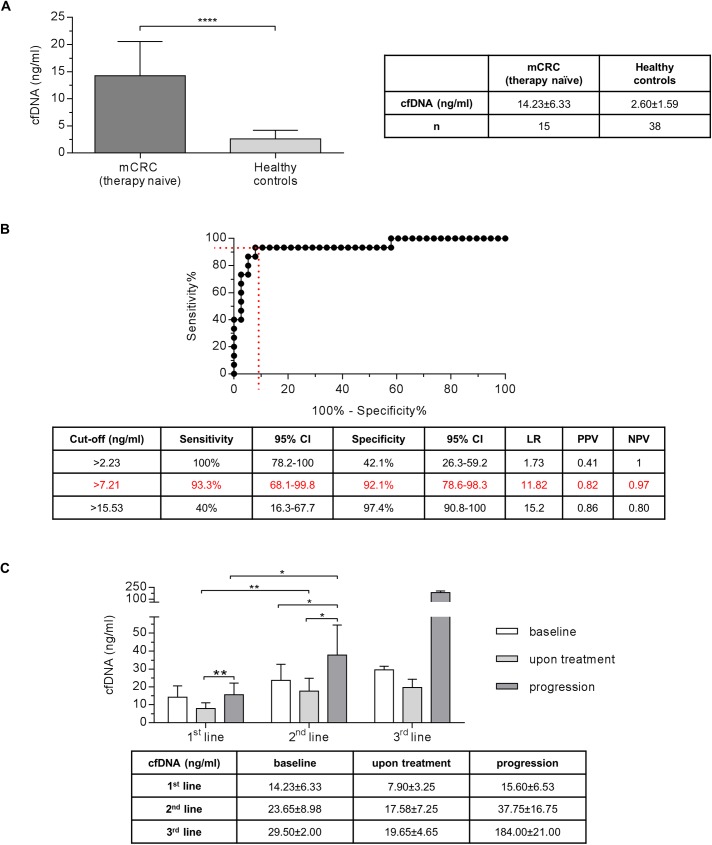
Diagnostic power of cfDNA in metastatic colorectal cancer patients and its changes under palliative treatment.(A) Therapy naïve patients with metastatic colorectal cancer (CRC) show significantly higher cfDNA concentration than healthy controls (Mann-Whitney, p<0.0001). (B) Receiver operating characteristic (ROC) of cfDNA level as a test parameter to discriminate patients with metastatic CRC from healthy controls. (C) CfDNA levels over the time course of therapy in 1st, 2nd and 3rd line treatment. The amount of cfDNA increases at time-point of progression in 1st and 2nd line (Mann-Whitney, p<0.01, p<0.05, respectively). CI = confidence interval, LR = likelihood ratio, PPV = positive predictive value, NPV = negative predictive value. Level of significance: * = p<0.05, ** = p<0.01, *** = p<0.001, **** = p<0.0001.